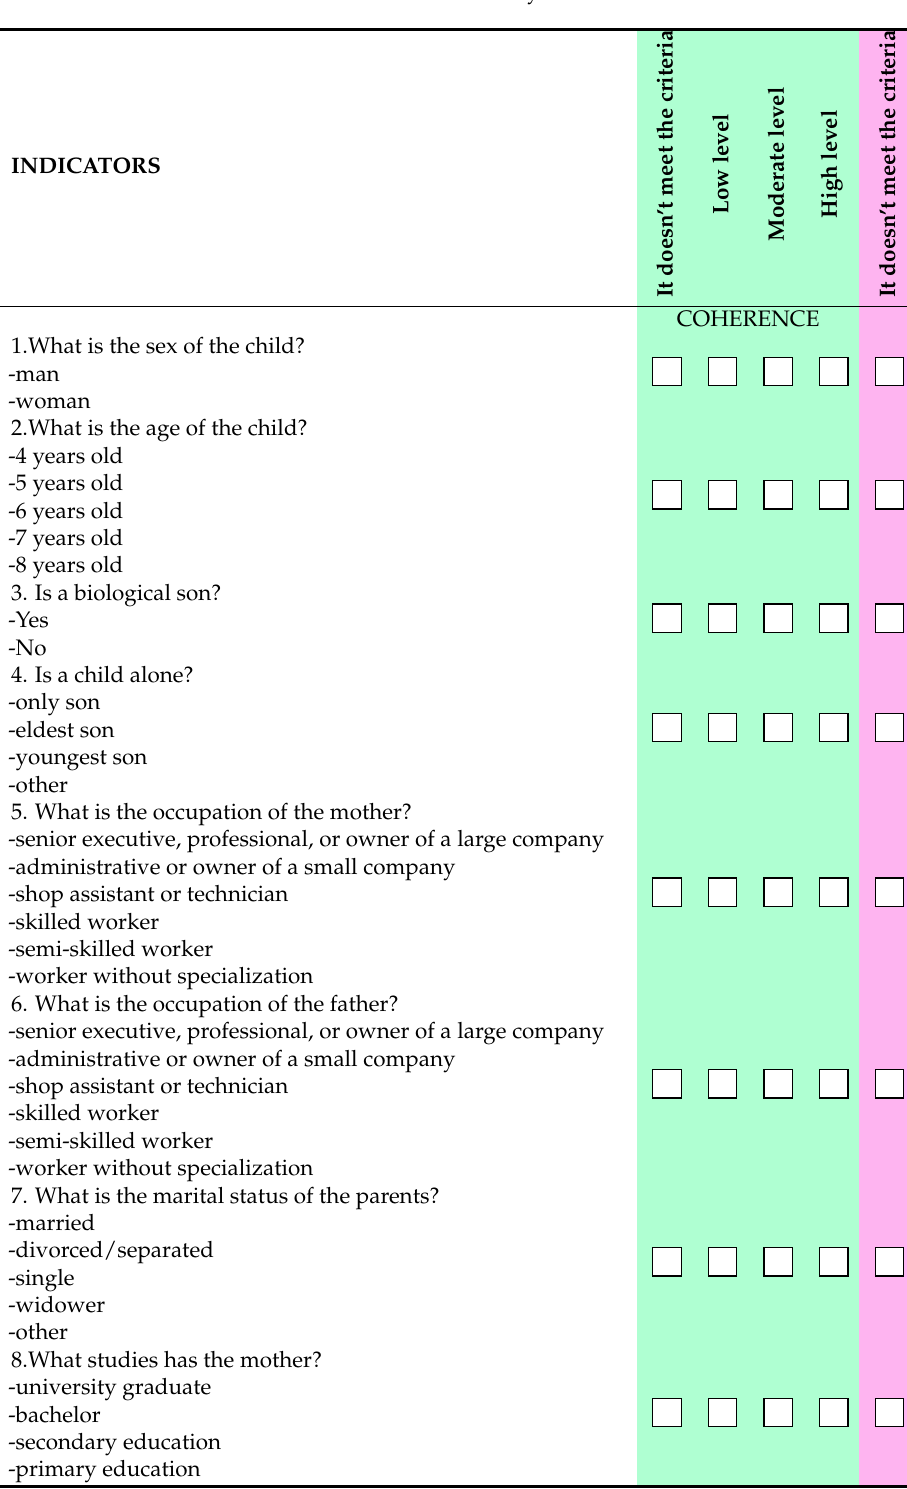
Table 1. Initial survey for